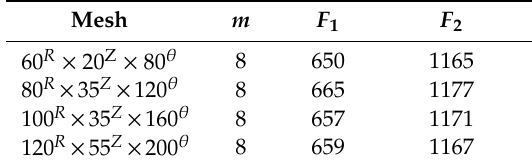
Table 2. Mesh dependence of oscillatory flow at Re T = 9938 and Re c = 936